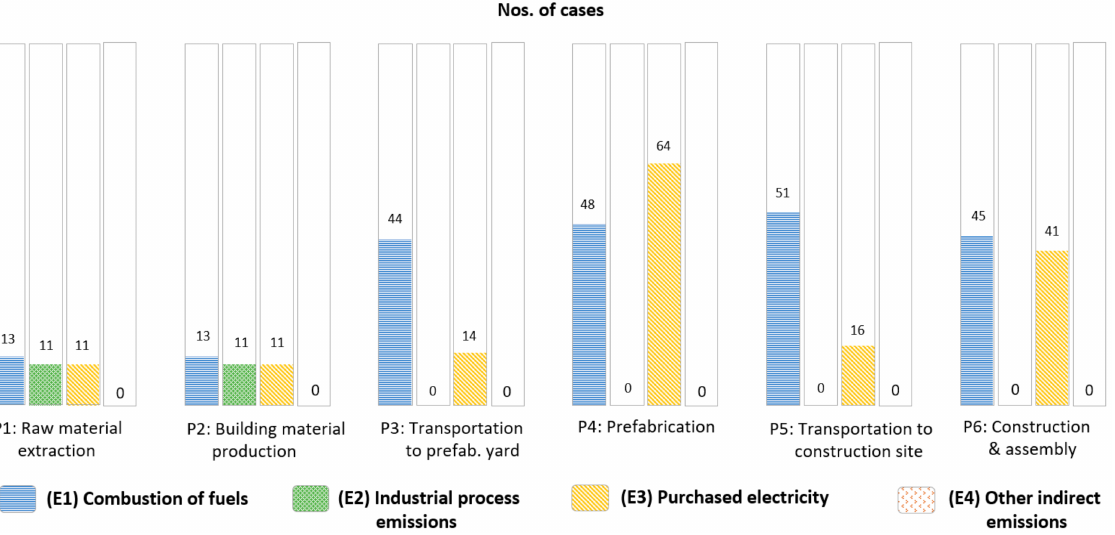
Figure 8. Number of cases considering various emission sources in different life cycle